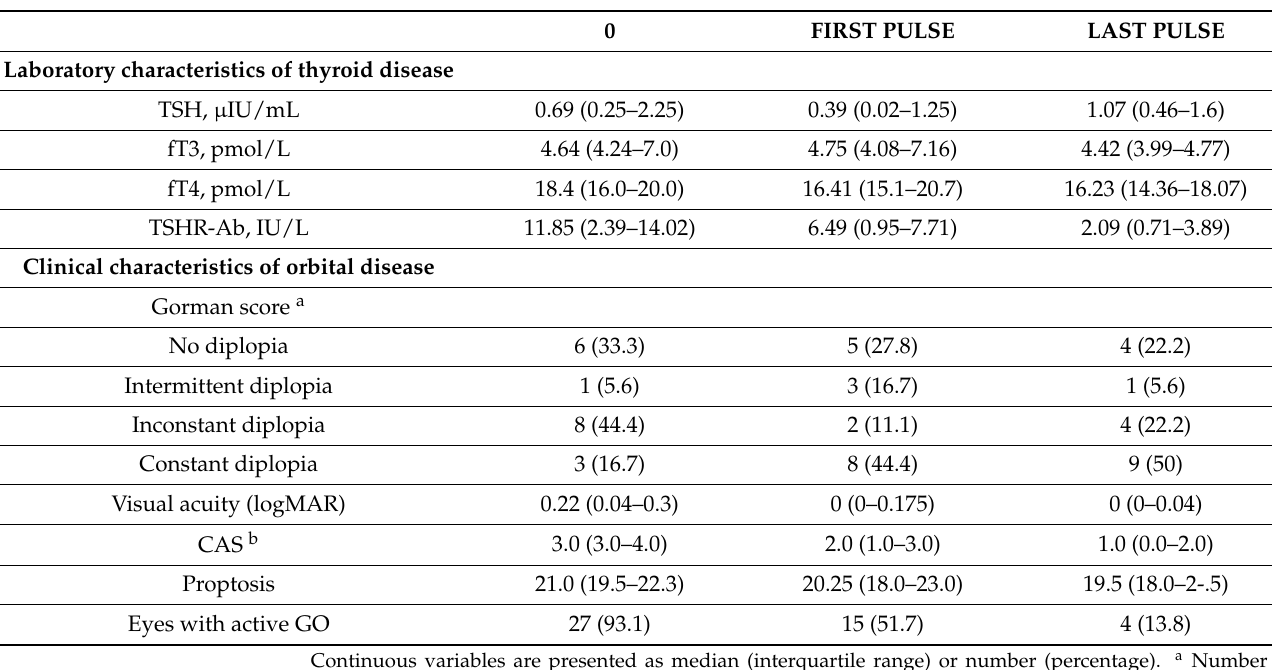
Table 2. Laboratory and clinical characteristics at three time